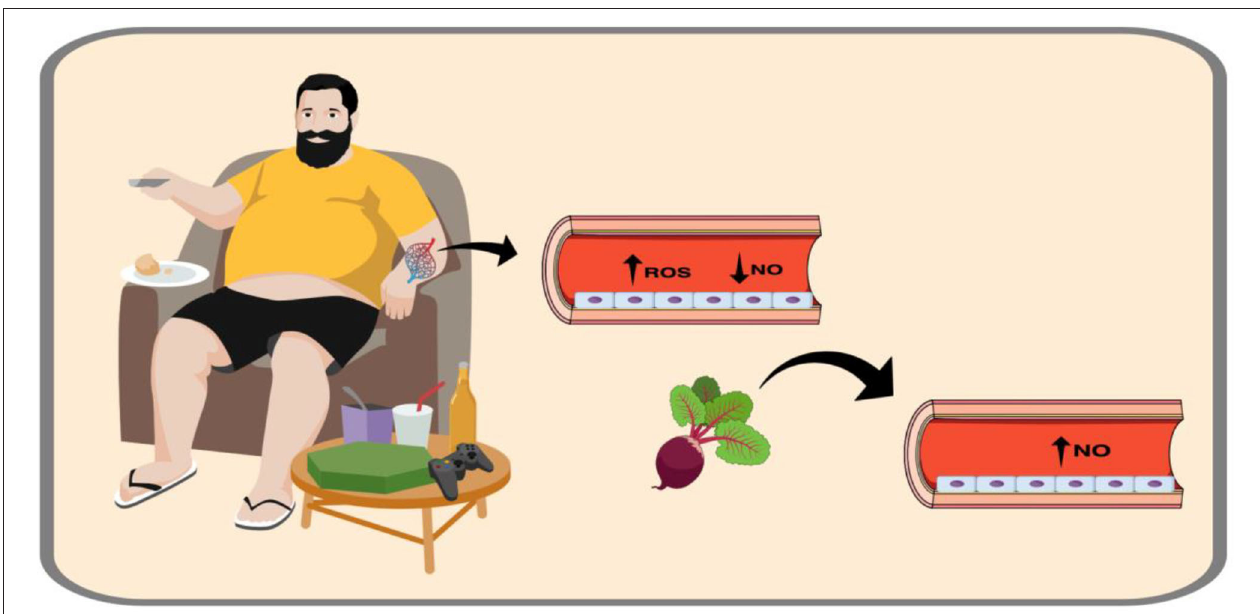
FIGURE 1 | The effect of lifestyle behaviors changes during COVID-19 quarantine on endothelial function. Social distancing was adopted as a way to reduce person-to-person Coronavirus 2019 transmission. However, home confinement may promote lifestyle behaviors changes as unhealthy diet and physical inactivity. Collectively, these unhealthy behaviors are associated with endothelial damage, the first step for the development of cardiovascular diseases. Since nitrate-rich beetroot juice ingestion has demonstrated positive effect on endothelial function due to its effects on nitric oxide bioavailability, its ingestion could be encouraged during COVID-19 quarantine in order to alleviate the potential negative effect of home confinement on cardiovascular